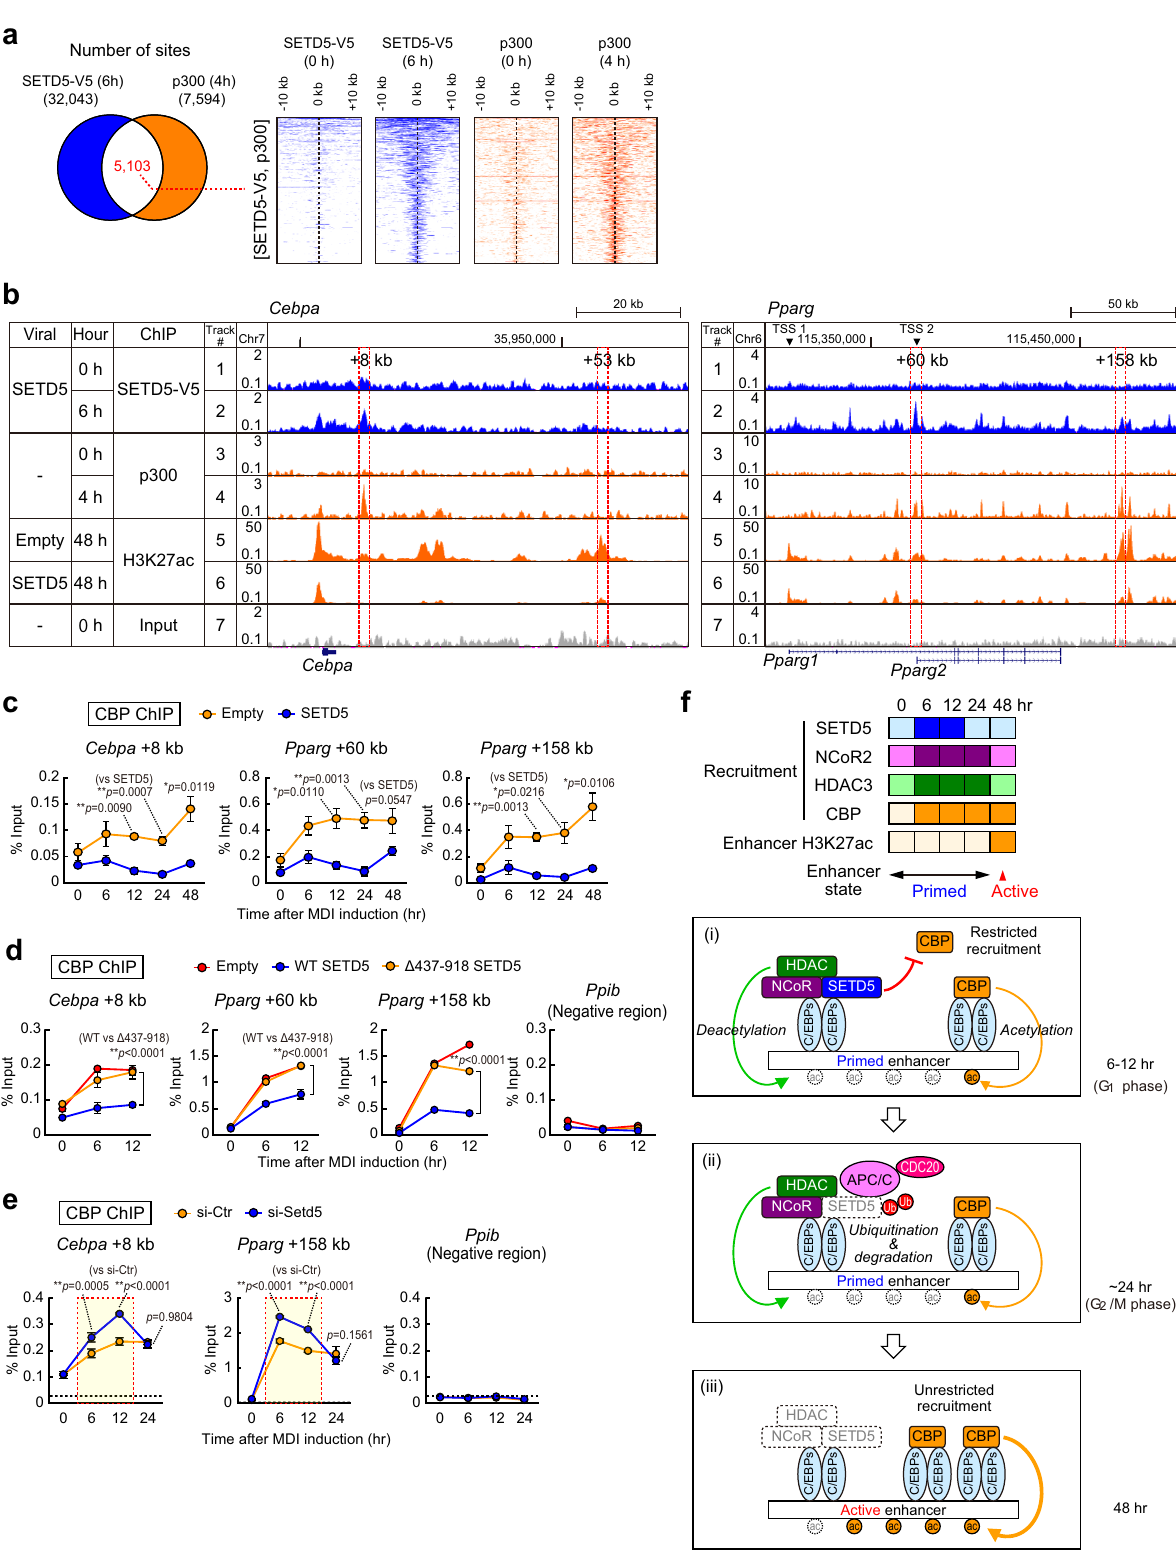
envelope fused to mouse SETD5 fragment (amino acids 49 to 93 or 1,241 to 1,291). IgG-F2104 which reacts with endogenous mSETD5 in immunoprecipitation and chromatin immunoprecipitation (ChIP) was used for ChIP-sequencing analysis.